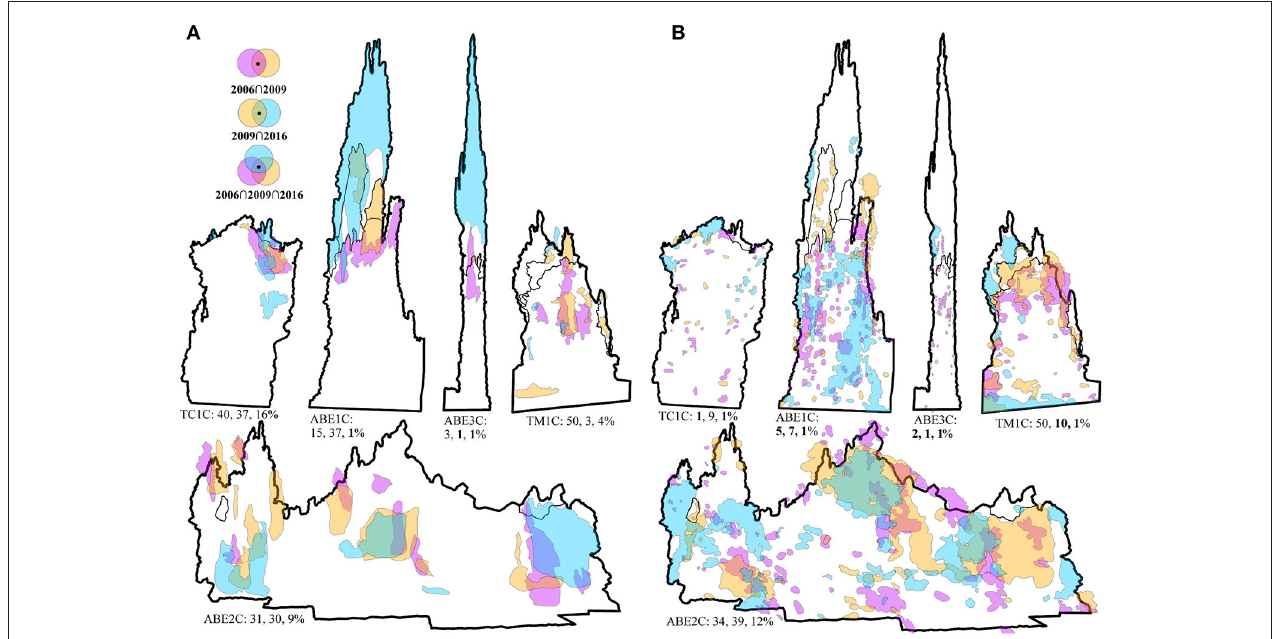
FIGURE 3 | The five hydrothermal vent edifices with the microdistribution of (A) “hotspots” between years ( ≥ 150 ◦ C) and (B) foundation species between years. The colored polygons represent the microdistributions observed during each survey: pink in 2006, orange in 2009, and blue in 2016. Thick black lines denote the study sites’ boundaries in 2016, while thin black lines denote previous years’ boundaries (i.e., edifice growth). The three values provided underneath each edifice are the percent of spatial overlap in the microdistribution between years (i.e., spatial intersection, ∩ ), where bolded values denote a statistical change in the microdistribution. For detailed statistical outputs, including the differences between observed and expected overlap, see Table 2 .